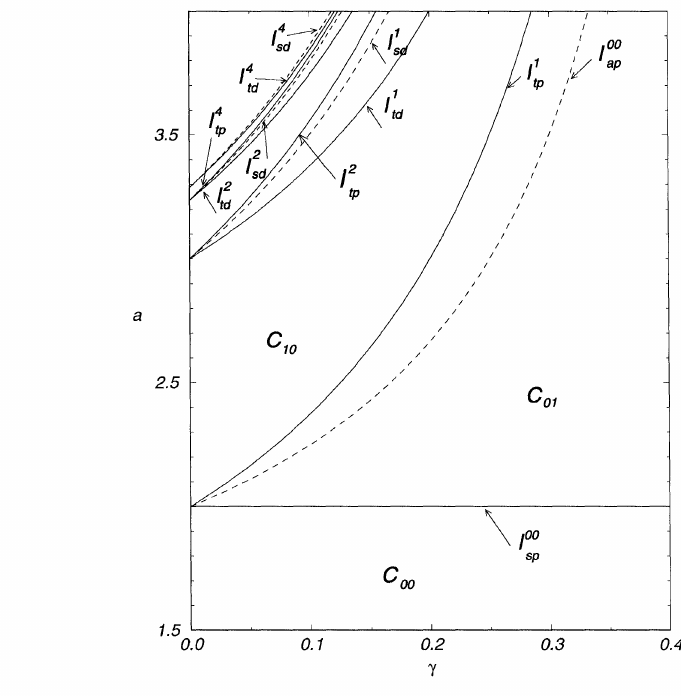
FIGURE 6 Bifurcational lines of antisymmetric periodic orbits on the pane of the parameters